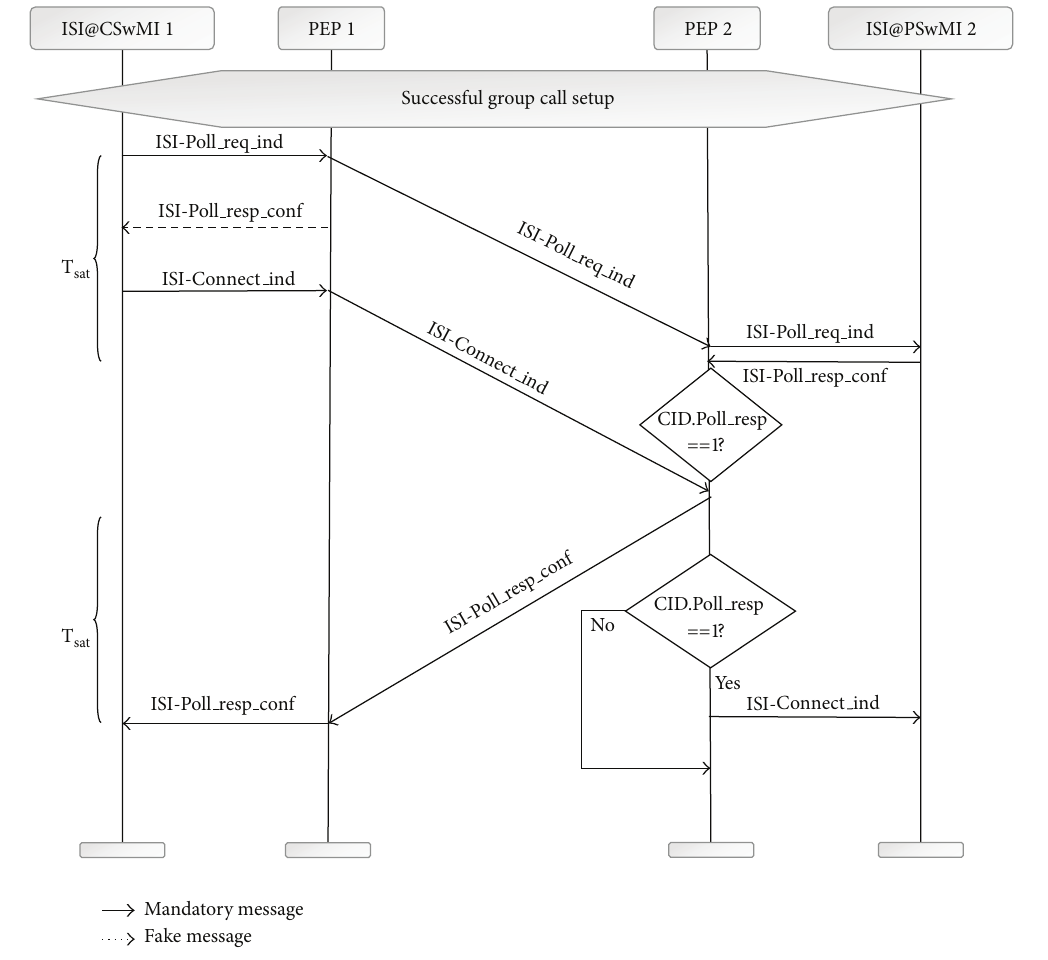
Figure 9: ISI information flow sequence with PEPs, acknowledged group call. Table 4: ISI backhauled TETRA group call setup times using